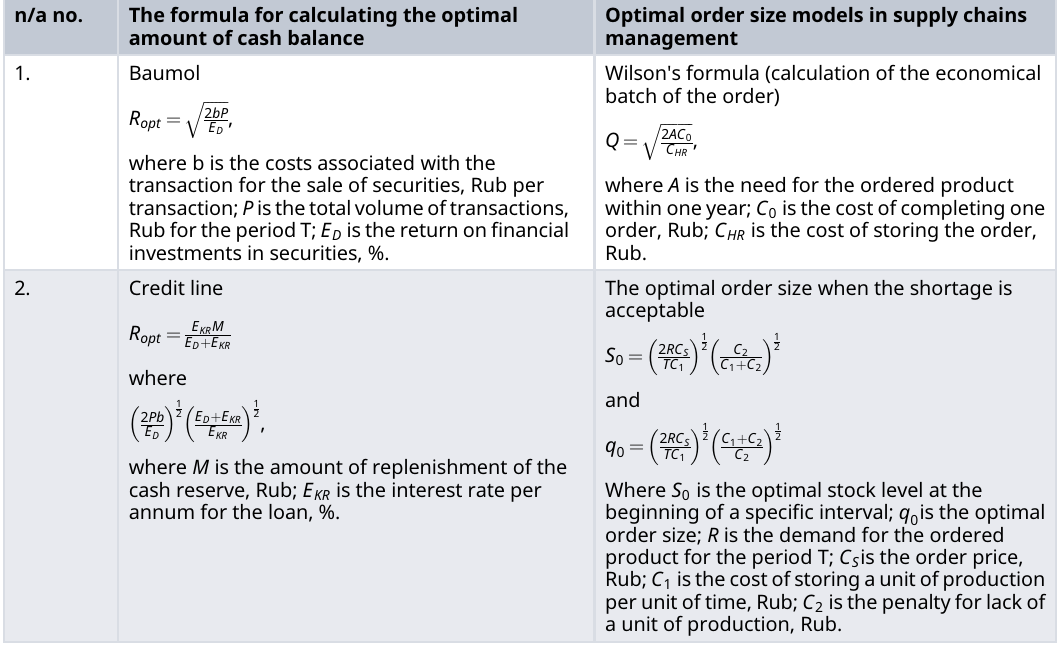
Table1.Formulasforcalculatingtheoptimalamountofcashreserveandvariousmodelsoftheoptimalorder size. n/a no.